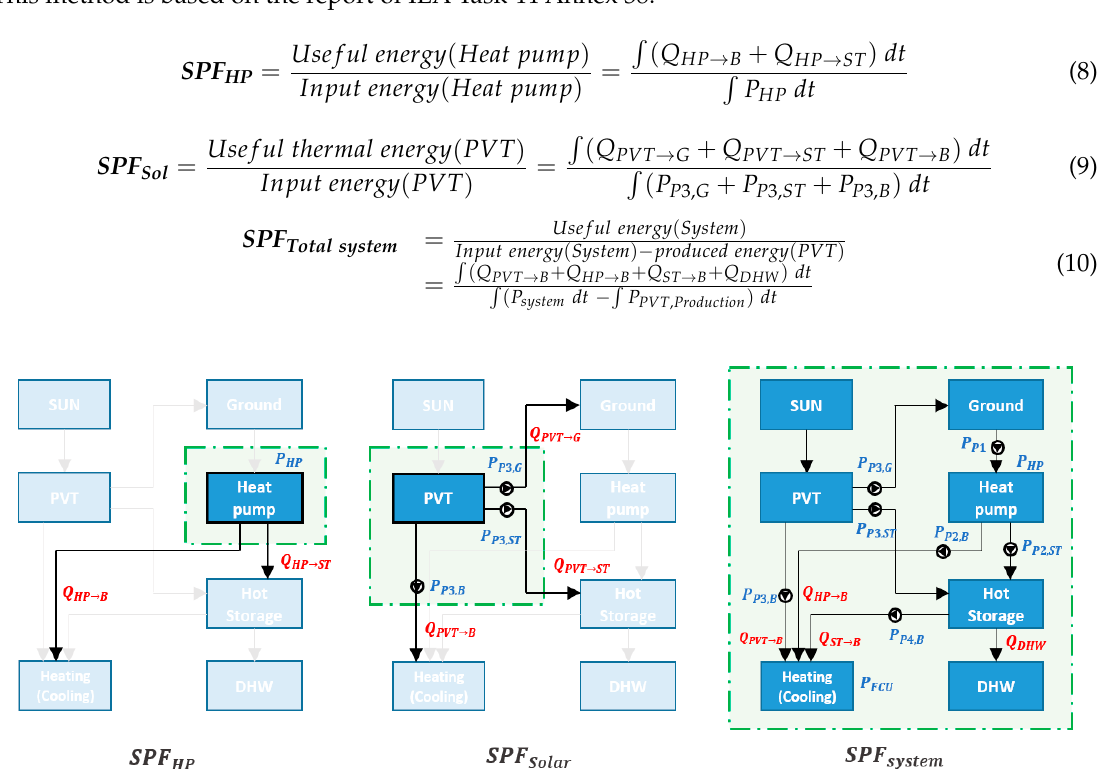
Figure 8. Calculation method of SPF.